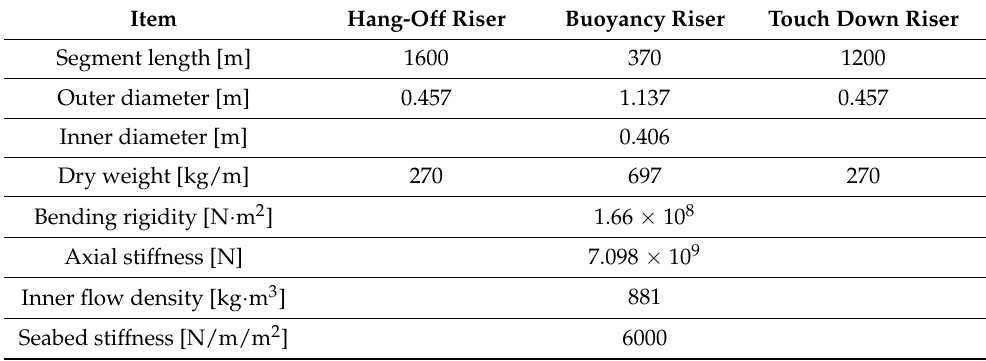
Table 3. Parameter of steel lazy wave riser [41].